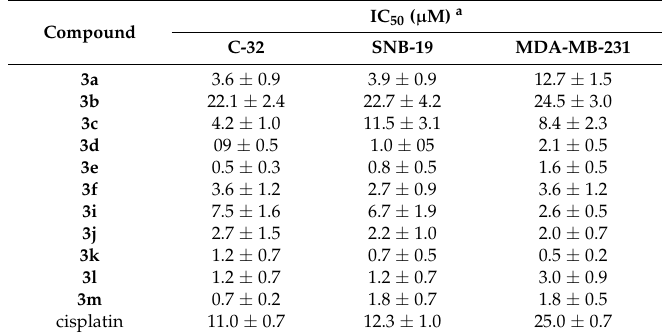
Table 1. Effect of 5-methyl-12( H )-quino[3,4- b ][1,4]benzothiazinium salts ( 3 ) and cisplatin (reference) on the viability of cells from three cancer cell lines studied.